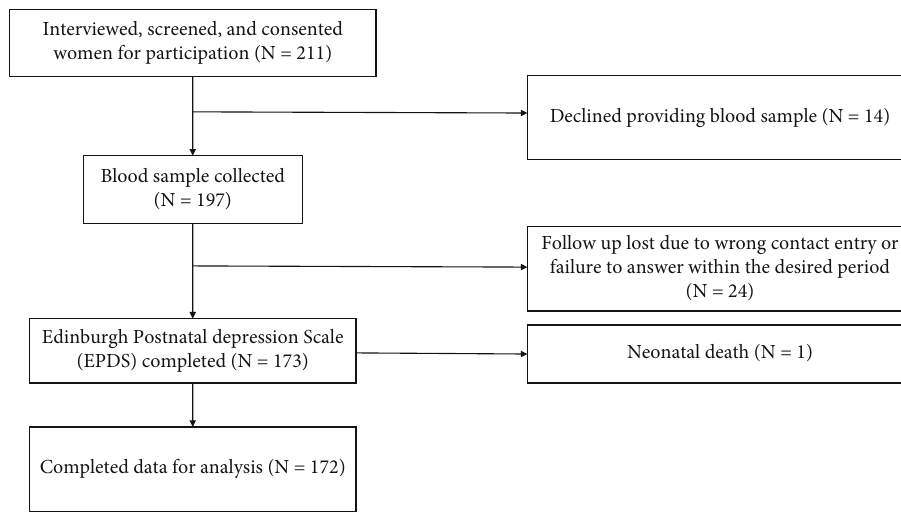
Figure 1: Flowchart of study